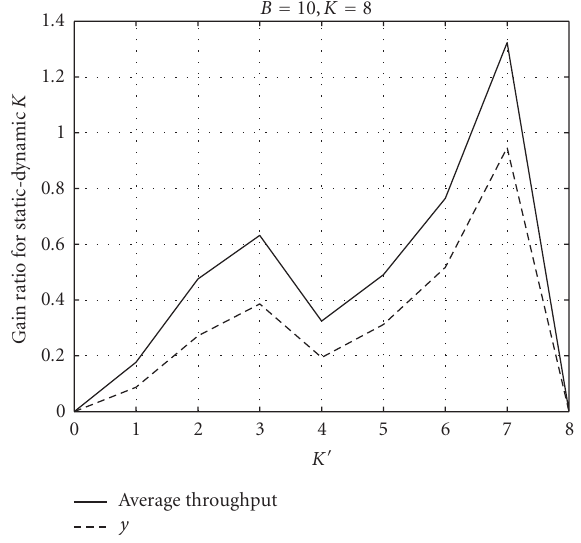
Figure 12: Stability region y i of the dynamic ( K (cid:5) = 1) and static ( K (cid:5) = 0) cases for K = 4 (nodes 3, 4, and 8 of the asymmetric network of Figure